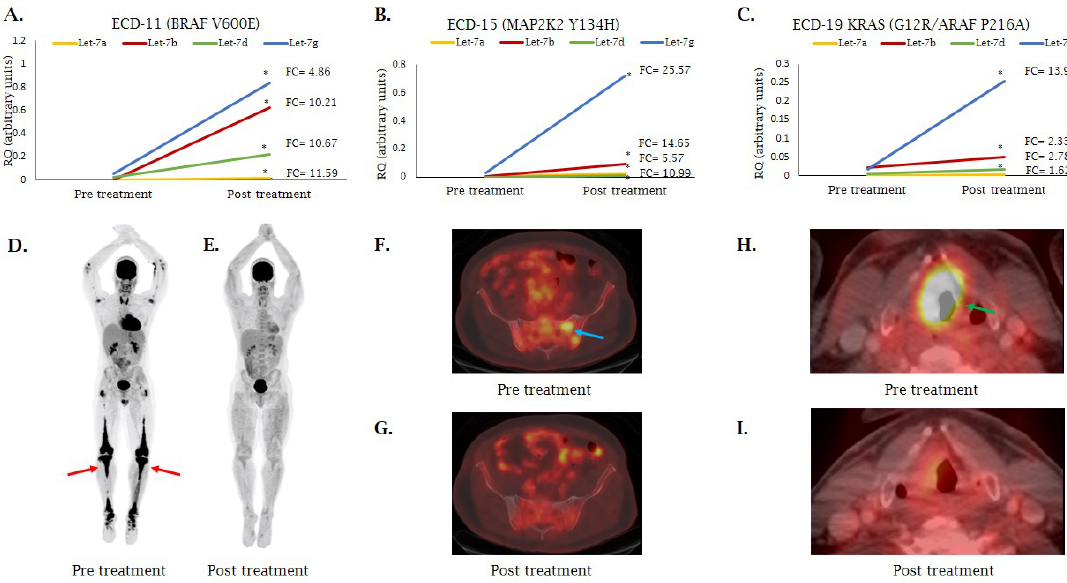
Figure 7. ( A – C ) MiRNA expression before and after treatment with the MEK inhibitor (cobimetinib). The graph shows the upregulation of let-7a-5p, let-7b-5p, let-7d-5p, and let-7g-5p after treatment with MEK inhibitor for 16 weeks. MiRNA expression was measured by qRT-PCR, normalized to spike-in control cel-miR-39. Fold change is shown on the right side of the line. * p < 0.05; ( D ) Full body maximal intensity projection (MIP) of FDG-PET demonstrates osseous disease, predominantly in the lower extremities, ( E ) that is resolved after four cycles of treatment with cobimetinib; ( F ) Axial fused FDG-PET / CT images demonstrate hypermetabolic iliac and sacral ECD lesions, ( G ) that are resolved after treatment. ( H ) Axial fused FDG-PET / CT images demonstrate hypermetabolic ECD lesions in the larynx, ( I ) that are resolved after treatment, with increased patency of the